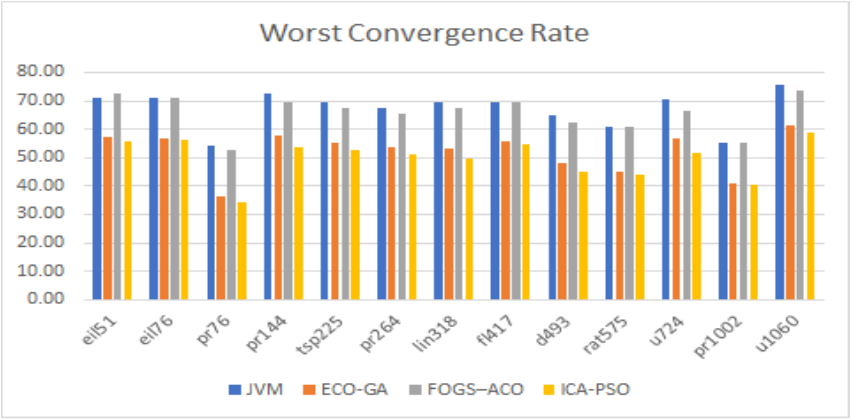
Figure 7. Worst convergence rate.